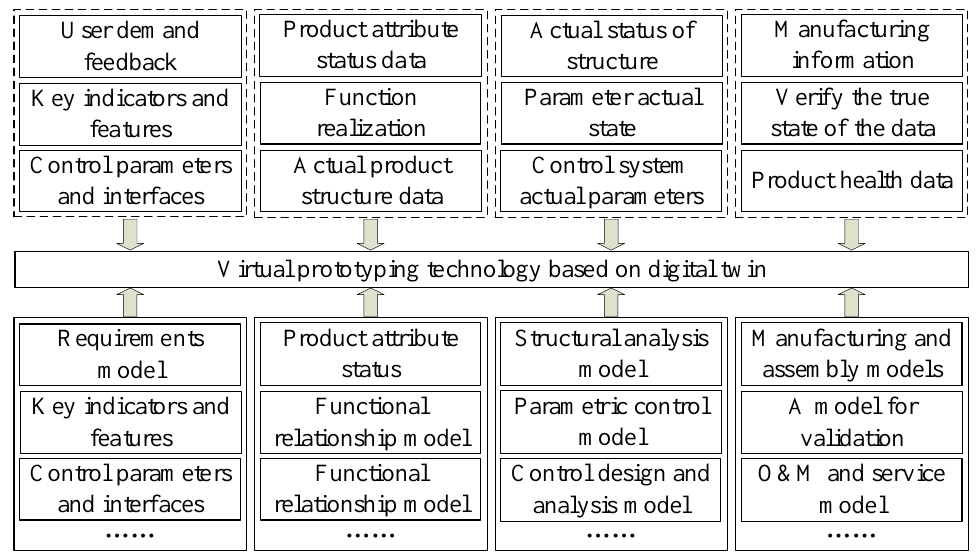
Figure 7. Virtual prototype design based on DMS-DT.